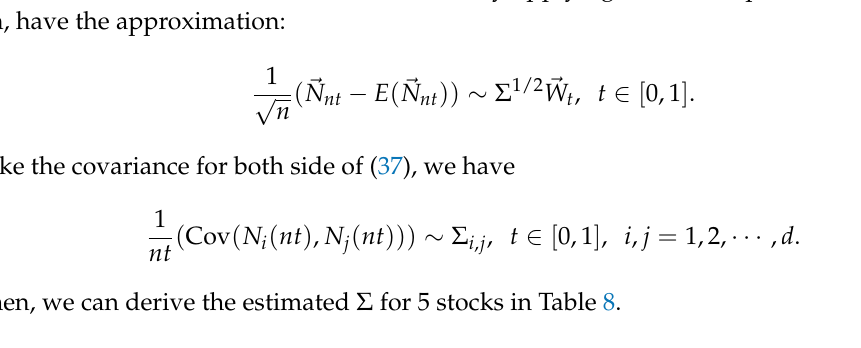
Table 8. Estimated covariance matrix Σ of 5 stocks via the FCLT assumption.